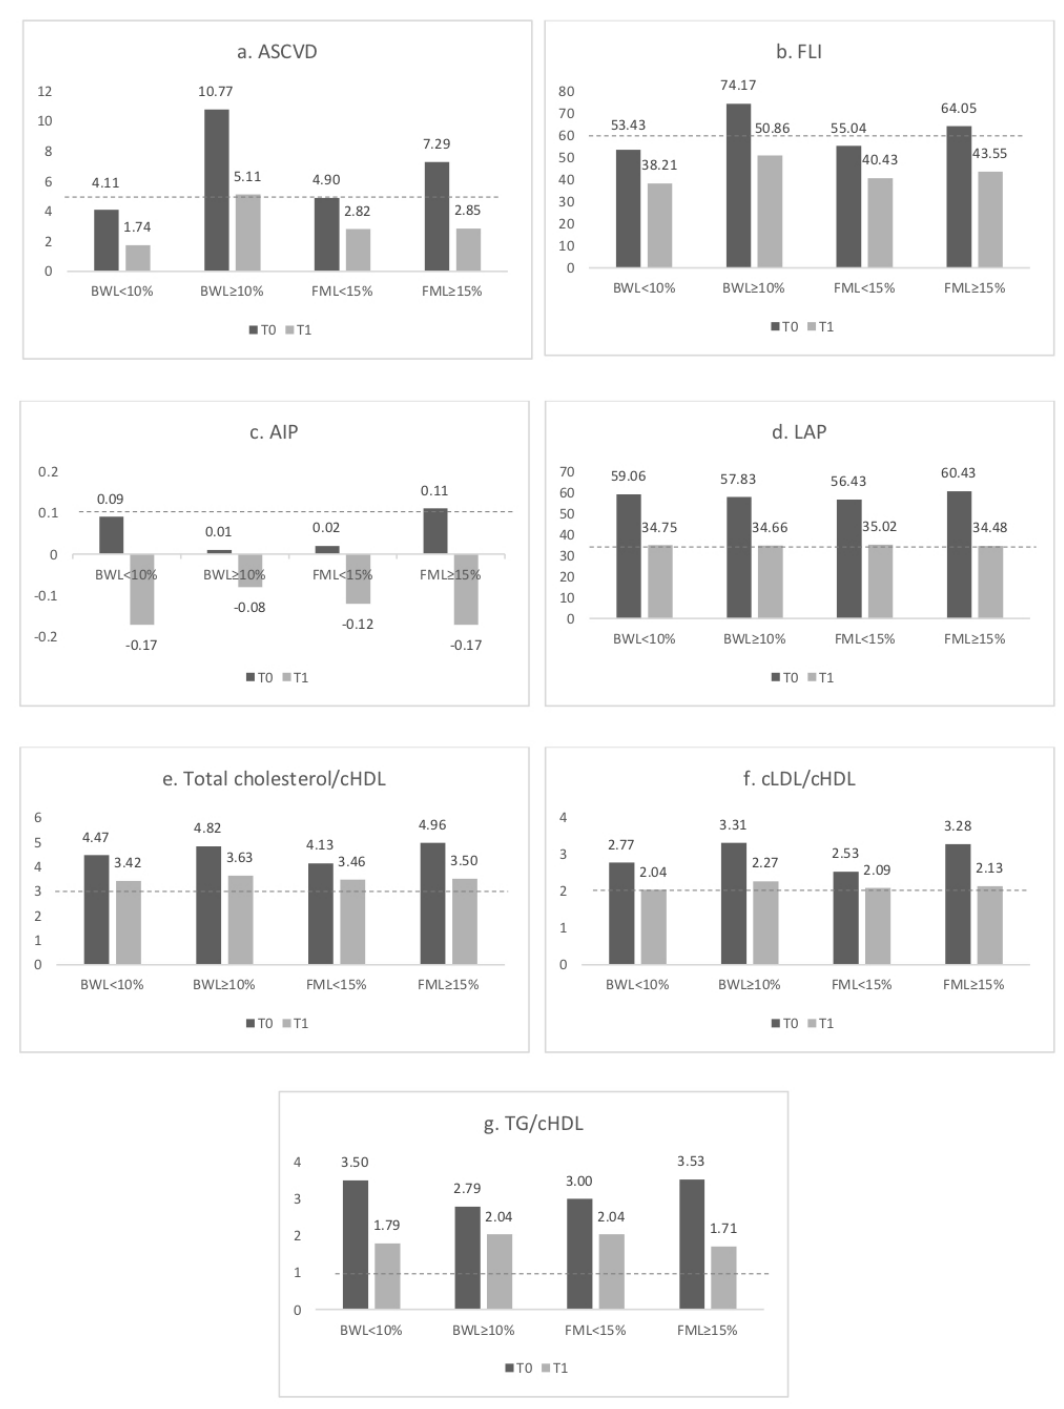
Figure 1. Modification of Cardiovascular Diseases and lipid profile-related risk indexes before (T0) and after the intervention (T1) according to Body Weight Loss (BWL) < 10% and 10% and Fat Mass Loss ≥ (FML) < 15% or 15%. ( a ) ASCVD, Atherosclerotic Cardiovascular Diseases; ( b ) FLI, Fatty Liver Index; ≥ ( c ) AIP, Atherogenic Index of Plasma; ( d ) LAP, Lipid Accumulation Product; ( e ) Total cholesterol / cHDL, total cholesterol-to-high density lipoprotein cholesterol ratio ( f ) cLDL / cHDL: low-density lipoprotein cholesterol-to-high density lipoprotein cholesterol ratio; ( g ) TG / cHDL, triglycerides-to-high density lipoprotein cholesterol ratio. The dotted lines refer to the cut-o ff for each